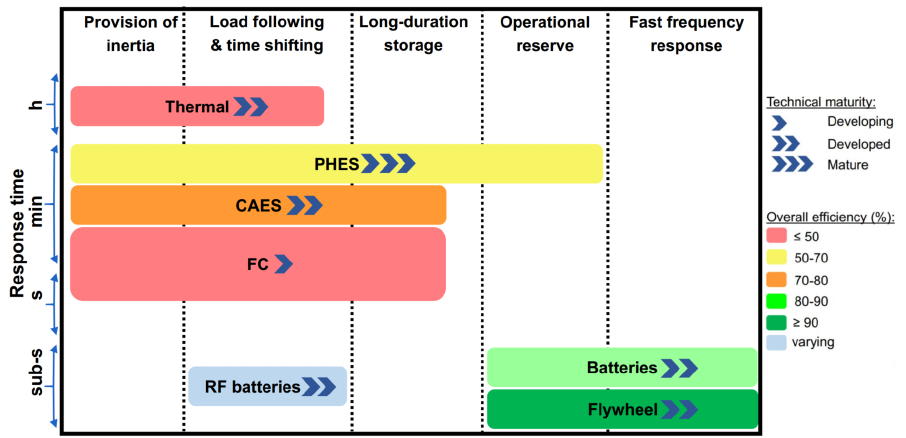
Figure 15. Comparison of various ESSs